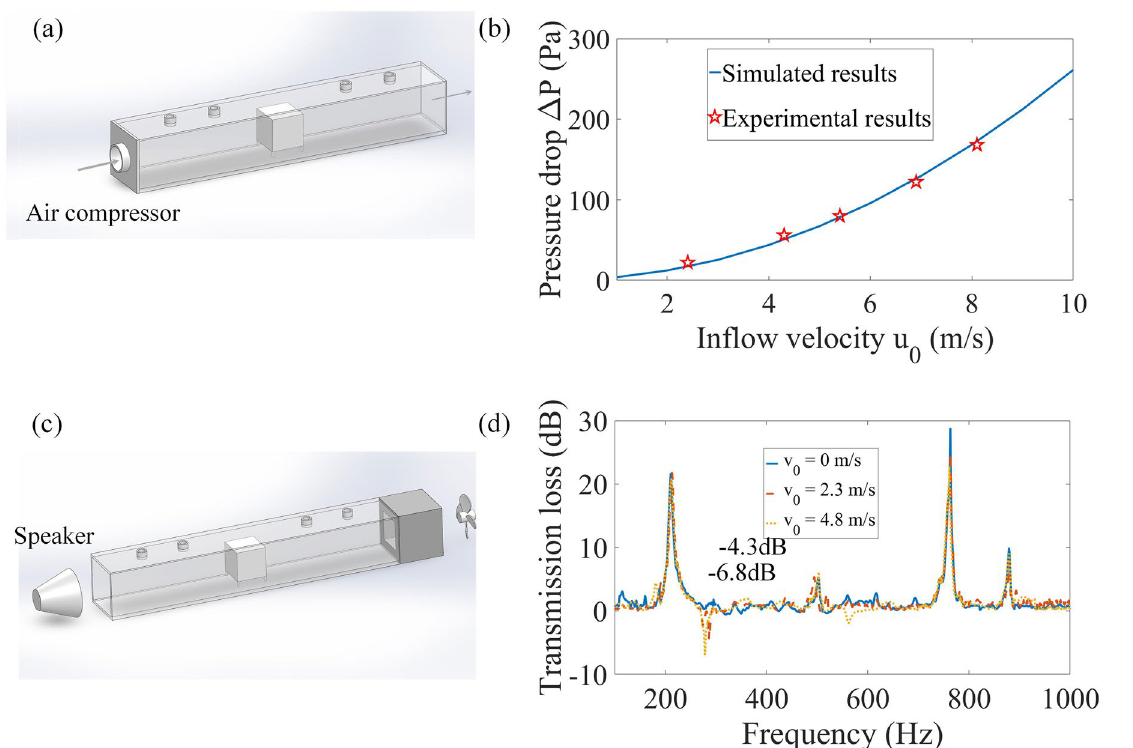
Figure 4. Influences of an air flow. ( a ) Experimental apparatus for evaluating the influence of the MFCB on the ventilation along a pipe. ( b ) Comparison of the measured and simulated results of the pressure drop induced by a MFCB with different input air flow velocities. ( c ) Experimental apparatus for measuring the transmission loss induced by a MFCB under an air flow. ( d ) Measured transmission losses with and without an air flow (the figure is created using SOLIDWORKS 2016, MATLAB 2016 and COMSOL